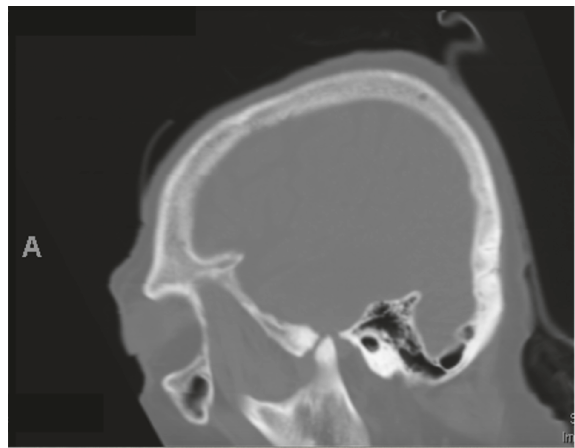
Figure 3: Sagittal CT demonstrates erosion of the skull base and protrusion of the